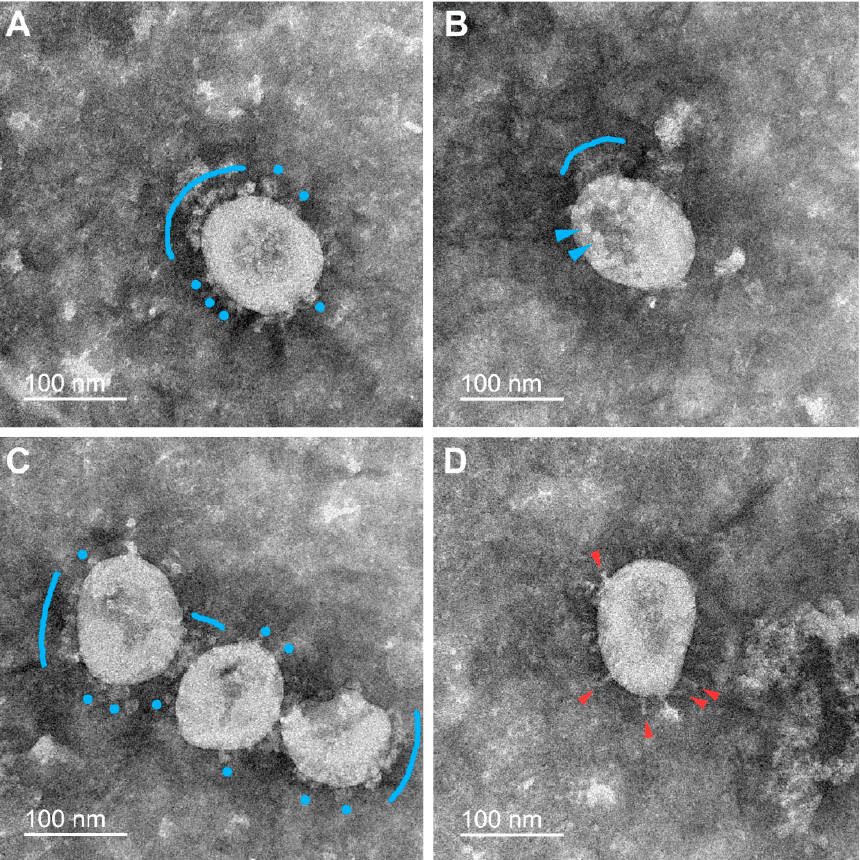
Figure 3. Electron microscopy images of SARS-CoV-2 virions subjected to UV inactivation (1 min). The flail-like (supposedly pre-fusion) spikes are marked in ( A – C ): flails (blue arrowheads), rounded flails (blue circles), and flail coats (blue arches). The needle-like (supposedly post-fusion) spikes are rarely observed on some virions ( D ) (red arrowheads).